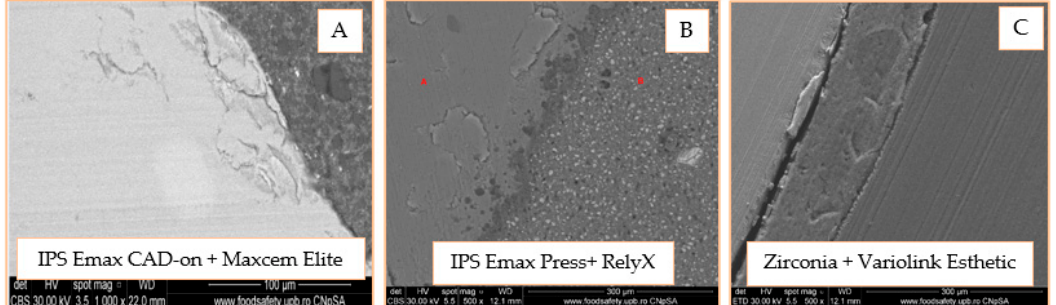
Figure 20. SEM 1000 × image of the onlay area—adhesive cement ( A ); SEM 500 × image of the onlay area—adhesive cement Figure 20. SEM 1000× image of the onlay area—adhesive cement ( A ); SEM 500 x image of the onlay area—adhesive cement ( B ); SEM 500× image of the onlay area—adhesive cement–dentin ( C ). ( B ); SEM 500 × image of the onlay area—adhesive cement–dentin ( C